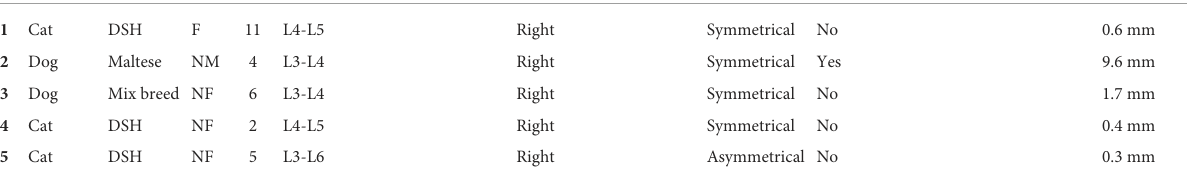
TABLE 1 Demographic details of patients included in the study with qualitative characteristics of the venous ring malformation. N Species